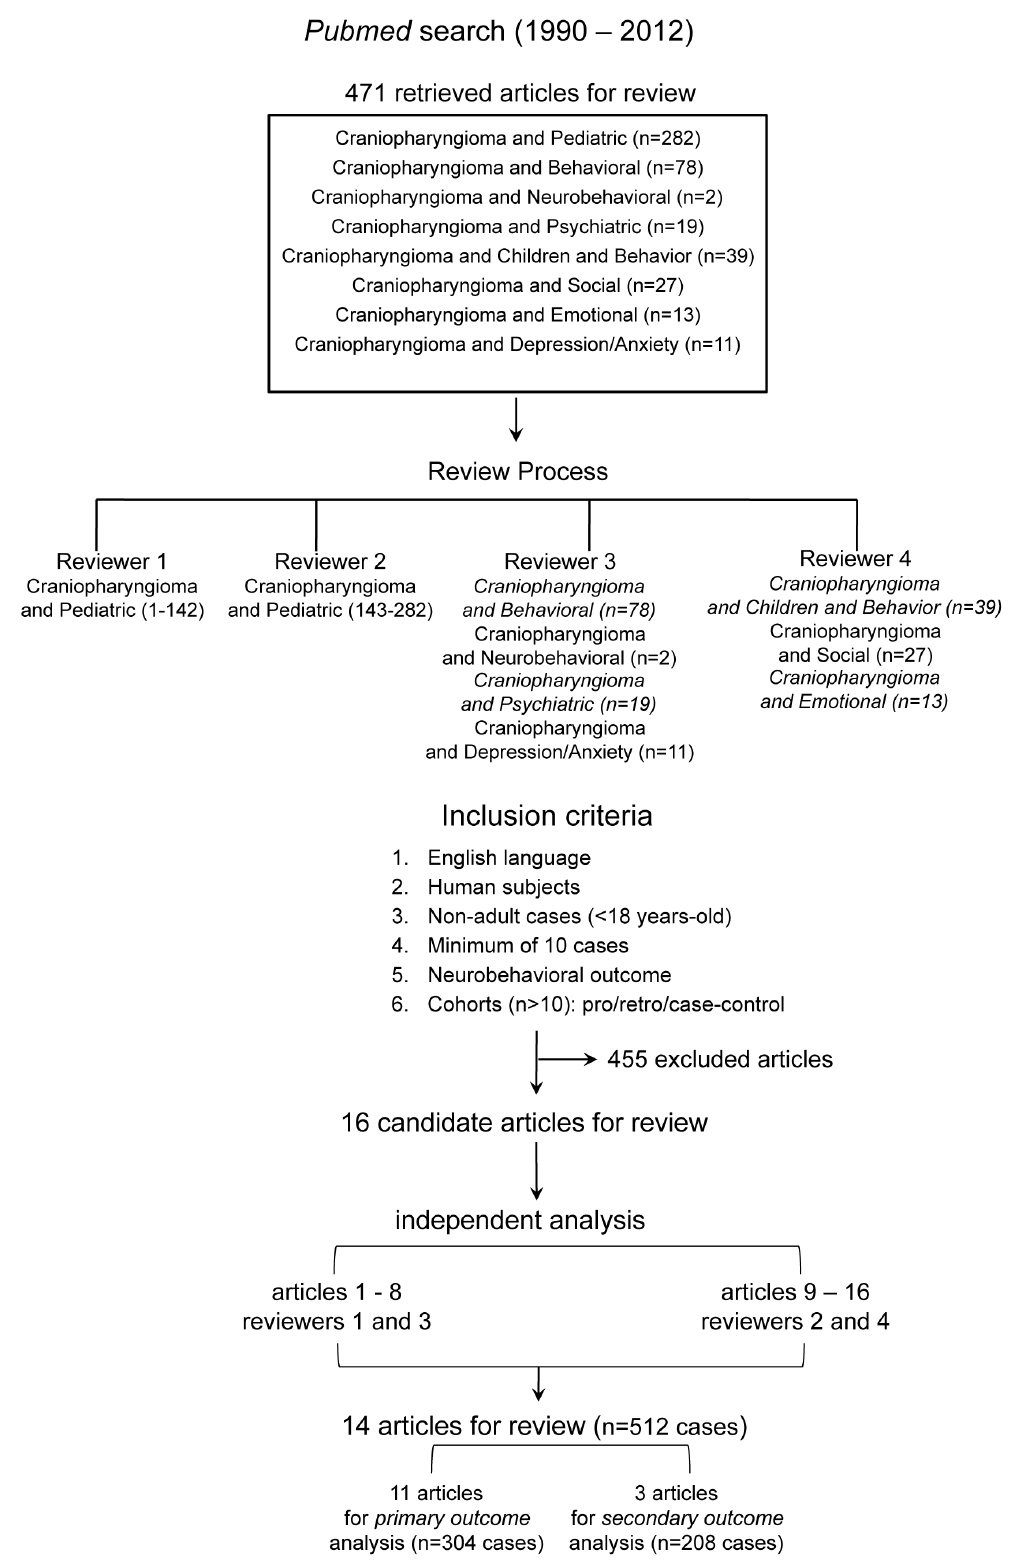
Figure 1. Flow diagram detailing the flow of information and study selection through the systematic review process.